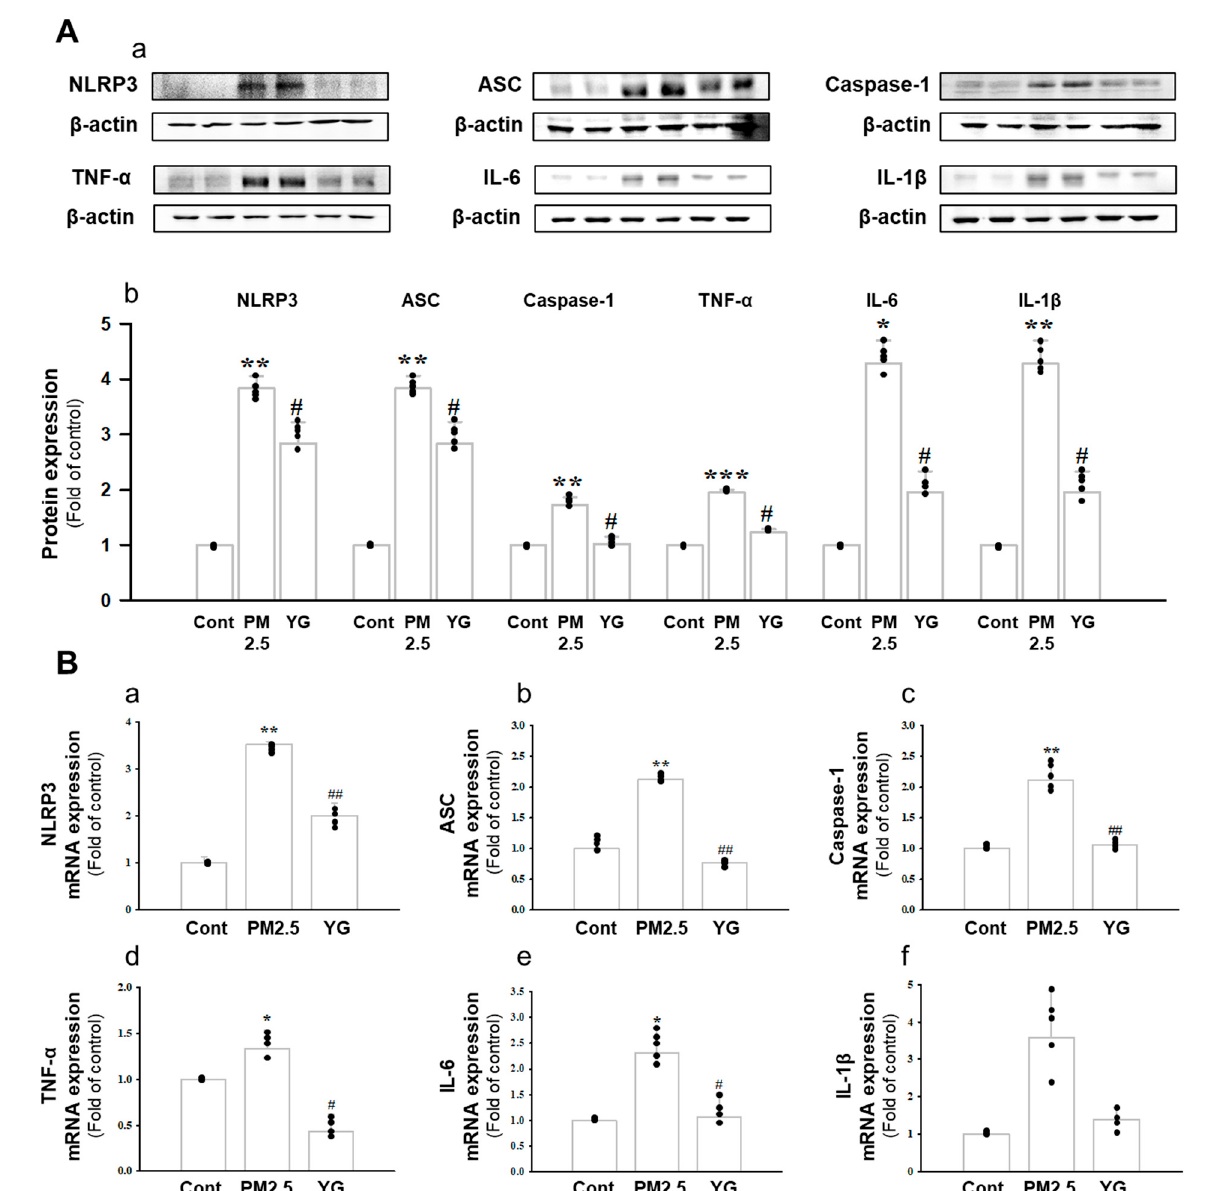
Figure 8. Treatment of YG-1 extract improved lung injury in fine particulate matter (PM2.5)-stimulated mice. Increased protein expression of NLRP-3, ASC, caspase-1, TNF- α , IL-6, and IL-1 β inflammatory cytokines in PM2.5 stimulated mice was improved by YG-1 treatment ( A ). Lung injury in PM2.5 stimulated mice increased NLRP-3, ASC, caspase-1, TNF- α , IL-6, and IL-1 β mRNA levels and was inhibited by YG-1 treatment ( B ). β -actin was used as loading controls for protein and mRNA expressions. Cont, control; PM2.5, PM2.5 exposure mice; YG-1, PM2.5 exposure mice + YG-1 treated (200 mg/kg/daily, orally); NLRP-3, NOD-like receptor pyrin domain-containning protein 3; ASC, apoptosis-associated speck-like protein containing a C-terminal caspase recruitment domain; TNF- α , tumor necrosis factor alpha; IL-6, interleukin 6; IL-1 β , interleukin 1 beta. Data are expressed as mean ± standard error. * p < 0.05, ** p < 0.01, *** p < 0.001 vs. control; # p < 0.05, ## p < 0.01 vs. PM2.5.